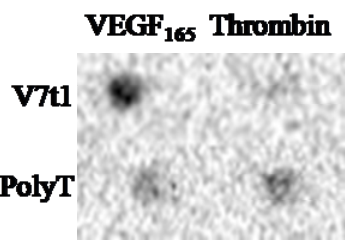
Figure 6. Evaluation of specificity of V7t1. A 5-pmol aliquot of each of proteins was immobilized on a single membrane. The membrane was incubated sequentially with 100 nM of the nucleic acid modified with FITC and with HRP-labeled anti-FITC